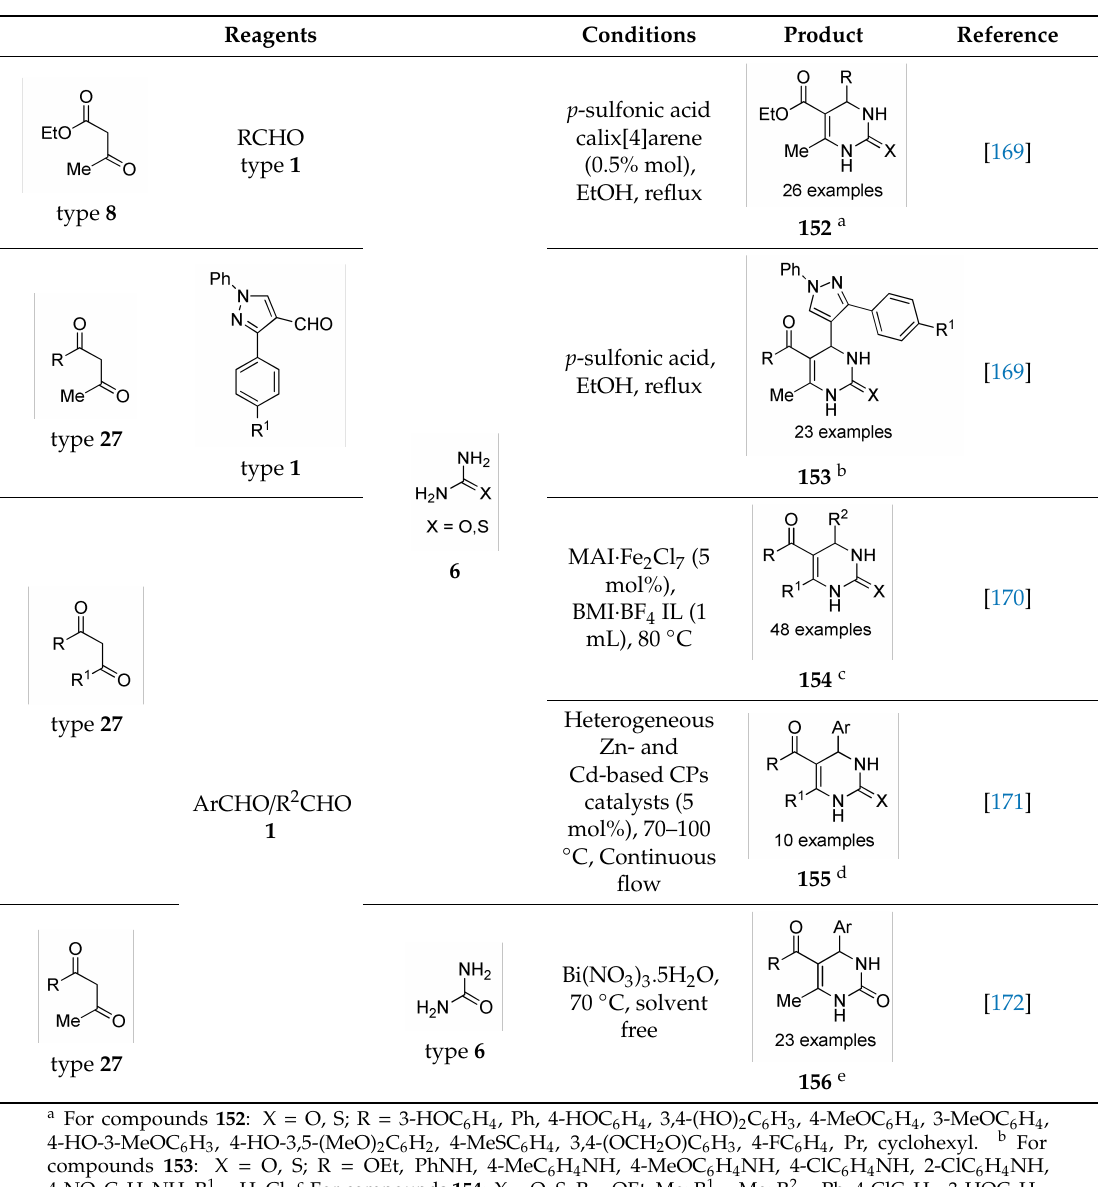
Table 1. Synthesis of dihydropyrimidone(thione)s 152 – 156 of antiproliferative interest mediated by Biginelli type three-component